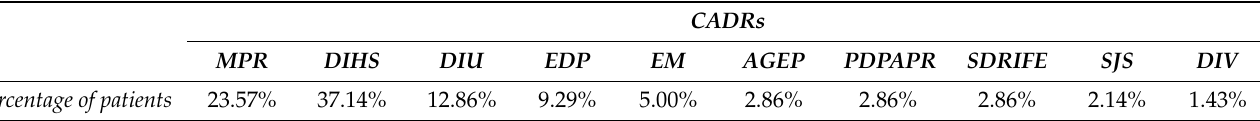
Table 3. The clinical spectrum of CADRs with percentages of